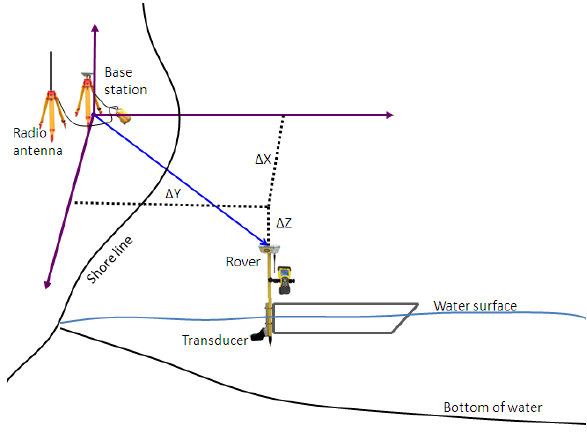
Figure 2: Hydrographic survey showing RTK GPS base station on land, and rover and hydrolite on survey boat.